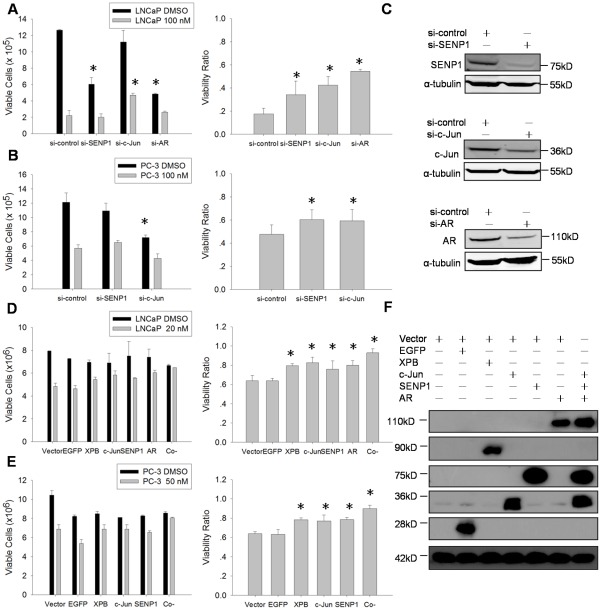
Down-regulation or over-expression of SENP1, c-Jun or AR inhibited Triptolide anti-PCa efficacy.(A) and (B) Down-regulation of SENP1, c-Jun or AR expression increased cell viability upon Triptolide treatment. LNCaP and PC-3 cells were transfected with specific siRNA against SENP1, c-Jun and AR. 24 h after transfection, the transfected cells were treated with 100 nM triptolide or vehicle control for 48 h, then the viable cell number was counted in each treatment. (A) Effect of knockdown SENP1, c-Jun and AR on Triptolide efficacy in LNCaP cell. Left chart shows the viable cell number in each treatment. Right chart shows the viability ratio. (B) Effect of knockdown SENP1 and c-Jun on Triptolide efficacy in PC-3 cell. * indicates P<0.05 (compared to control). (C) Down-regulation of SENP1, c-Jun and AR protein levels by siRNA in (A) and (B). (D) and (E) Over-expression of SENP1, c-Jun and AR rescued cell viability upon Triptolide treatment. PCa cells were transfected or cotransfected with 800 ng SENP1, c-Jun and AR expression plasmids DNA as indicated. EGFP protein was used as a negative control and the Triptolide binding protein XPB was used as a positive control. Empty vector was used as blank control and to keep the total amount of plasmids DNA equal in each well. 48 h after transfection, cells were treated with Triptolide for another 48 h and viable cell number were counted. (D) Effect of ectopic expression or coexpression of SENP1, c-Jun and AR on Triptolide efficacy in LNCaP cells. (E) Effect of ectopic expression or coexpression of SENP1 and c-Jun on Triptolide efficacy in PC-3 cells. * indicates P<0.05 (compared to control). (F) Ectopic expression or coexpression of SENP1, c-Jun and AR in PCa cells evaluated by Western blot using anti-Flag and anti-HA antibodies.